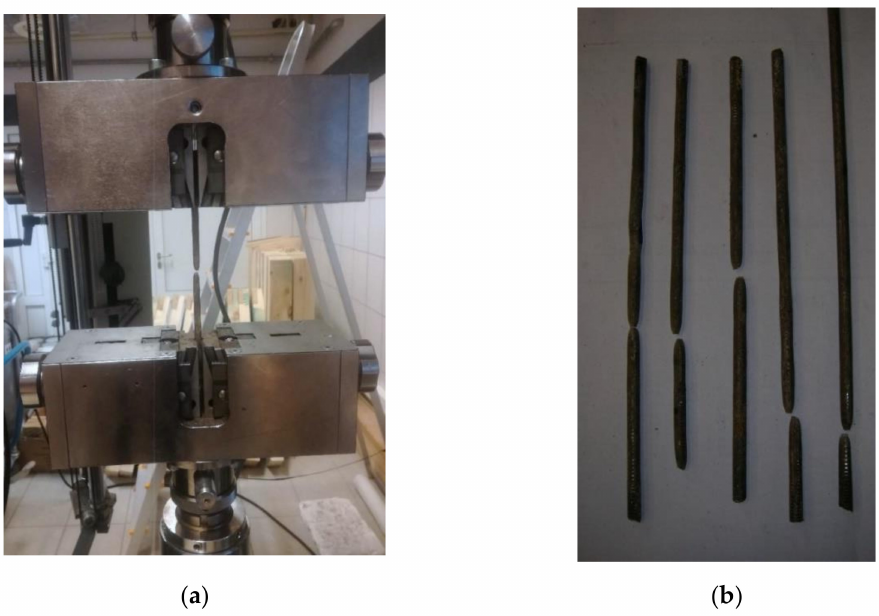
Figure 4. Uniaxial tensile tests: ( a ) Test setup; ( b ) steel bars after failure.